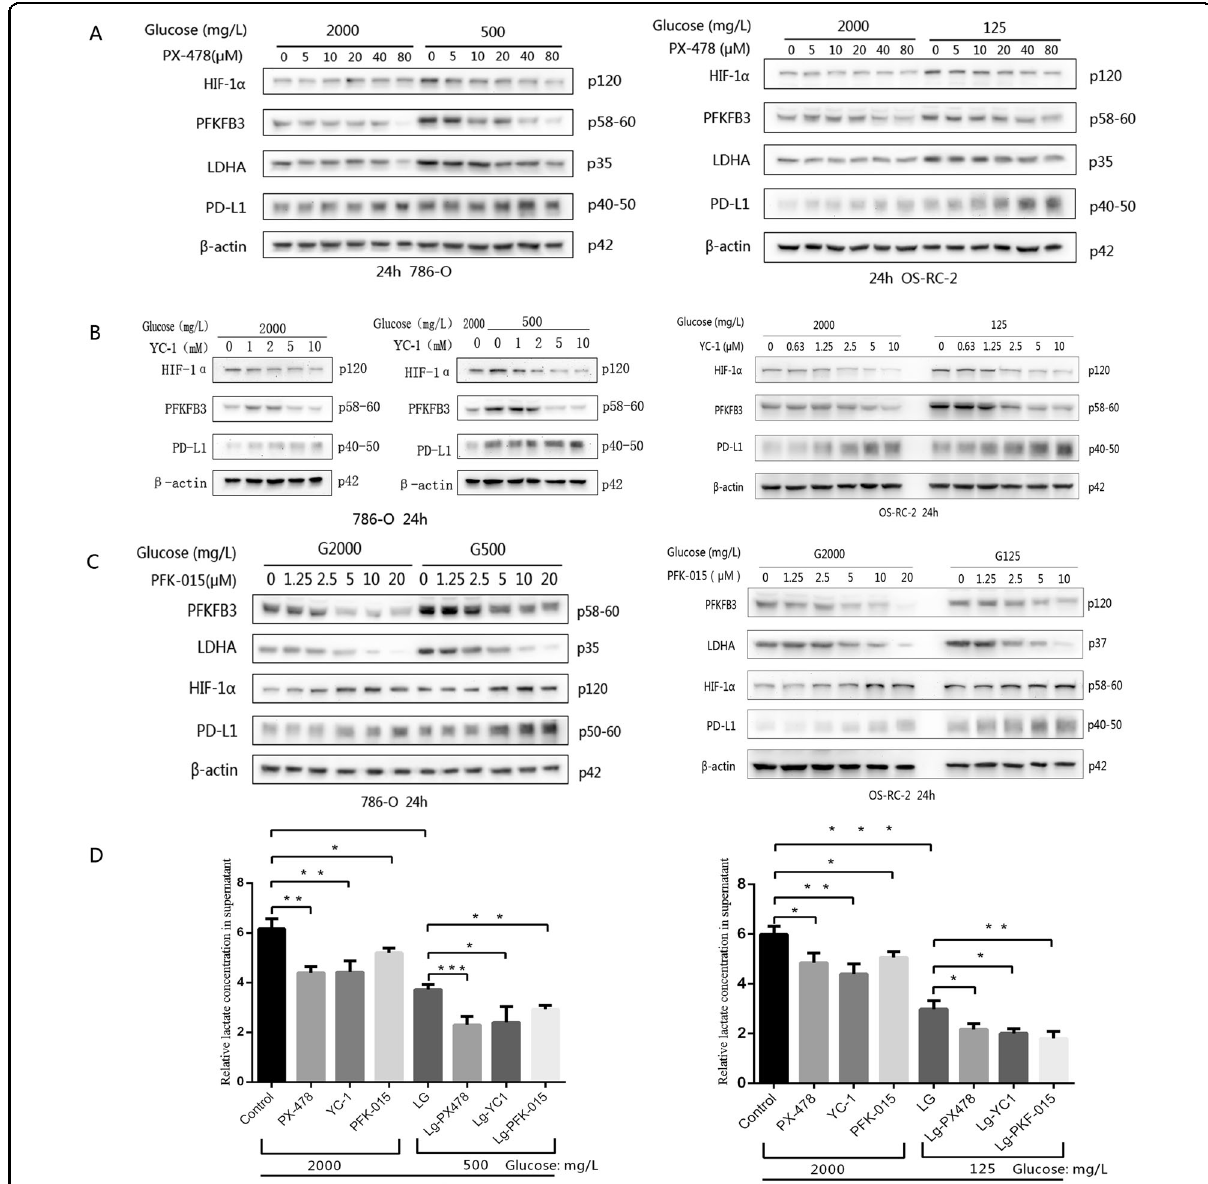
Fig. 3 After adding various protein inhibitors to the RPMI 1640 or low-level glucose culture medium system and performing a 24-h incubation, the expression levels of the glycolysis-regulating enzyme HIF-1 α , the key enzymes PFKFB3 and LDHA, lactic acid and PD-L1 in the two cell lines were detected by western blotting. A After the addition of the HIF-1 α inhibitor PX-478 under normal RPMI 1640 or low-glucose culture medium conditions, the expression levels of regulatory enzyme, key enzymes and PD-L1 were detected. B Glycolysis-regulating enzyme, key enzyme and PD-L1 expression levels were evaluated in both cell lines after the addition of another HIF-1 α inhibitor, YC-1. C After the PFKFB3 inhibitor PFK-015 was added, glycolysis-regulating enzyme, key enzyme and PD-L1 expression levels were assessed in the two cell lines. D The LD level of two cell lines in RPMI 1640 or low-glucose culture medium treated with the three inhibitors mentioned above is shown. The concentrations of PX-478, YC-1 and PFK-015 were 40 μ M, 10 μ M and 10 μ M, respectively. Independent experiments were performed in triplicate. Data are expressed as mean